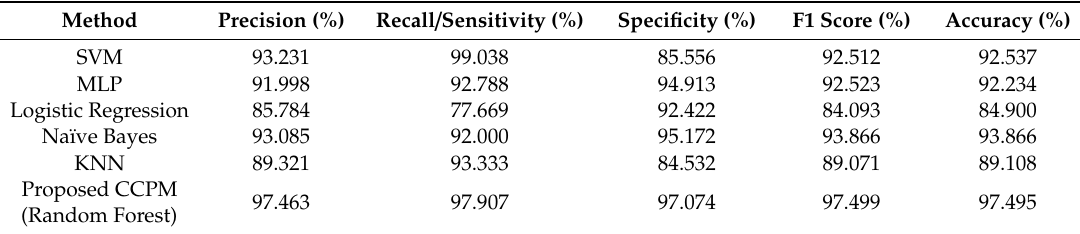
Table 21. Performance evaluation results based on iForest and SMOTETomek for Cytology.